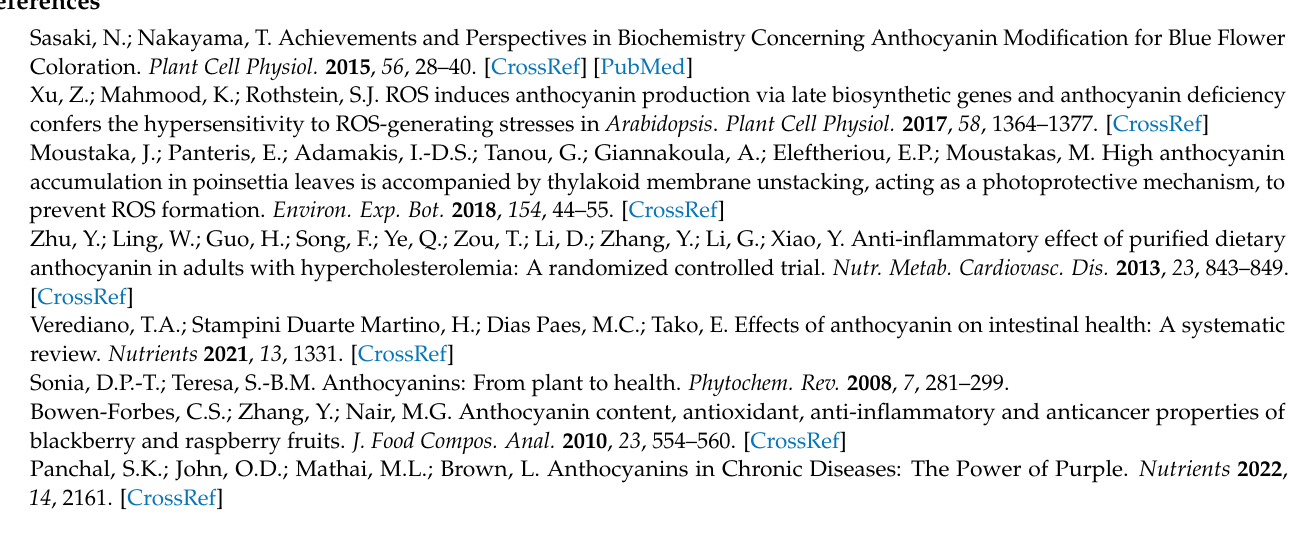
Table S2: Sequences of primers used for qRT-PCR; Table S3: RNA integrity number (RIN) value of RNA samples; Table S4: Summary of RNA-seq data from pink sample (P) and red sample (R); Figure S1: DEGs involved in plant hormone transduction; Figure S2: Agarose gel electrophoresis image of qRT-PCR